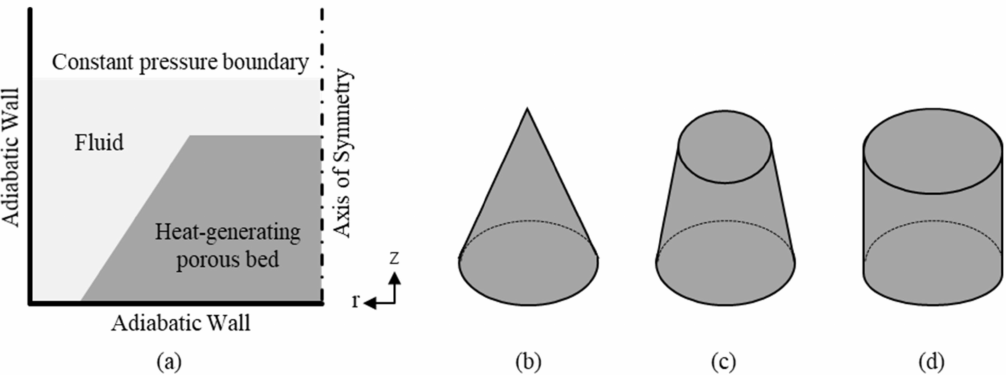
Figure 5. Examples of the porous bed modeling in cylindrical coordinate system. ( a ) Cross section. ( b ) Cone shape bed. ( c ) Trapezoid shape bed. ( d ) Cylinder shape